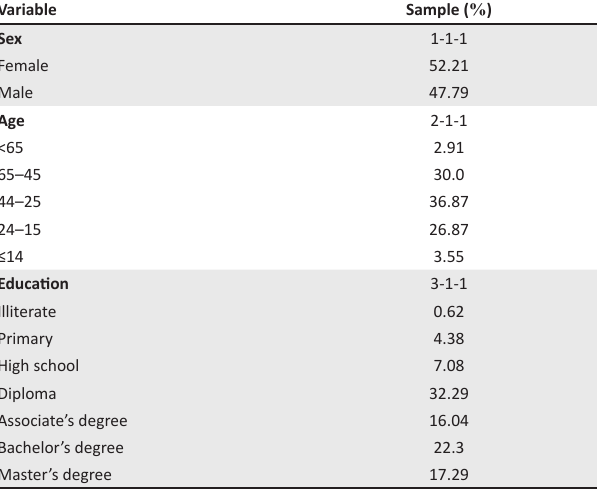
TABLE 4: Sample community information based on age, sex and